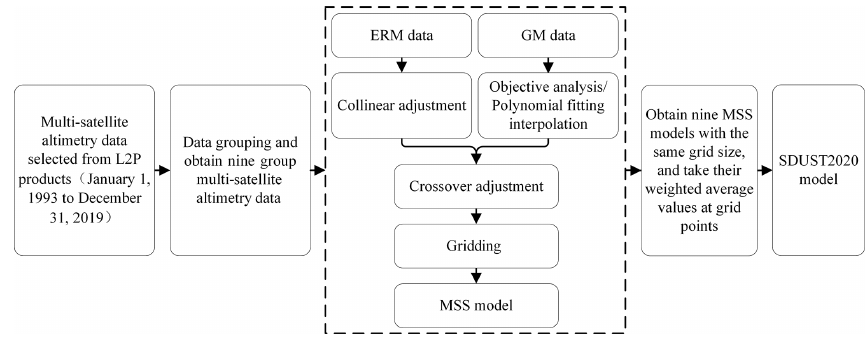
Figure 2. Data processing of L2P products to establish the SDUST2020 model.